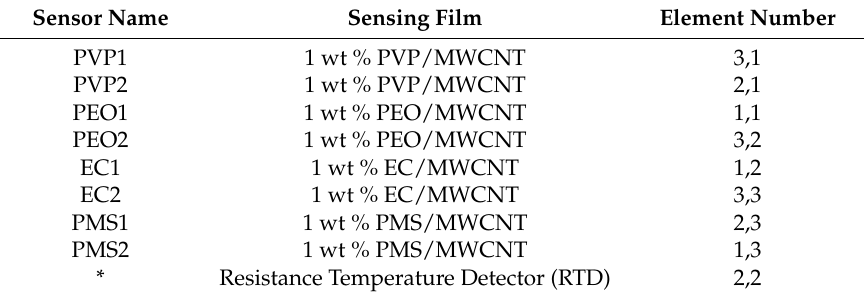
Table 1. Details of polymers in sensor